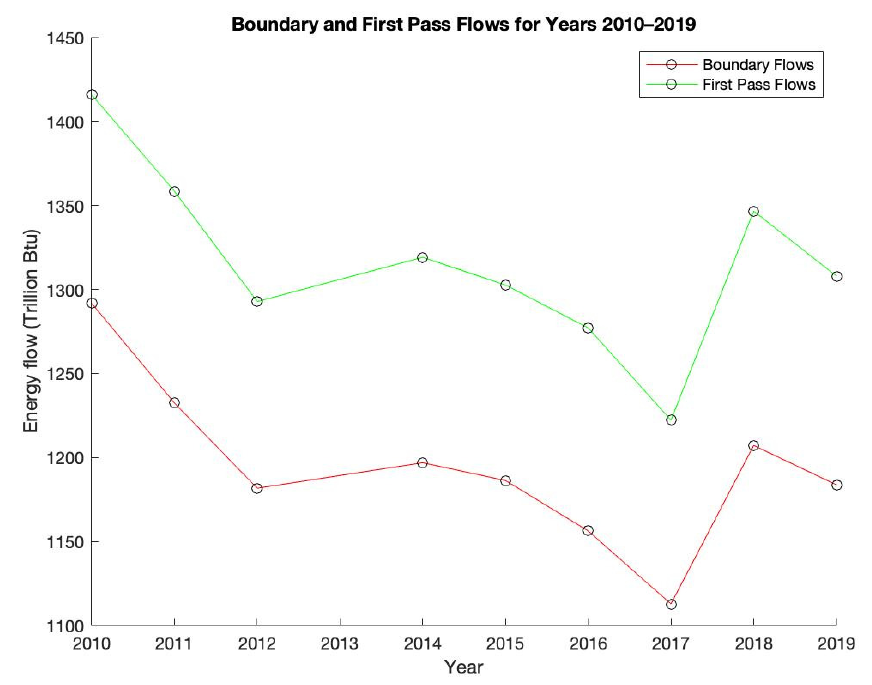
Figure 4. Boundary and first pass flows for Maryland’s energy industry from 2010–2019. Boundary and first pass flows exactly mimic TST and, when combined, make up 99.99% of the TST every year from 2010–2019. This shows that cycled flows are practically negligible, meaning energy flows are generally used by compartments once, and energy is either passed to another compartment or expelled from the